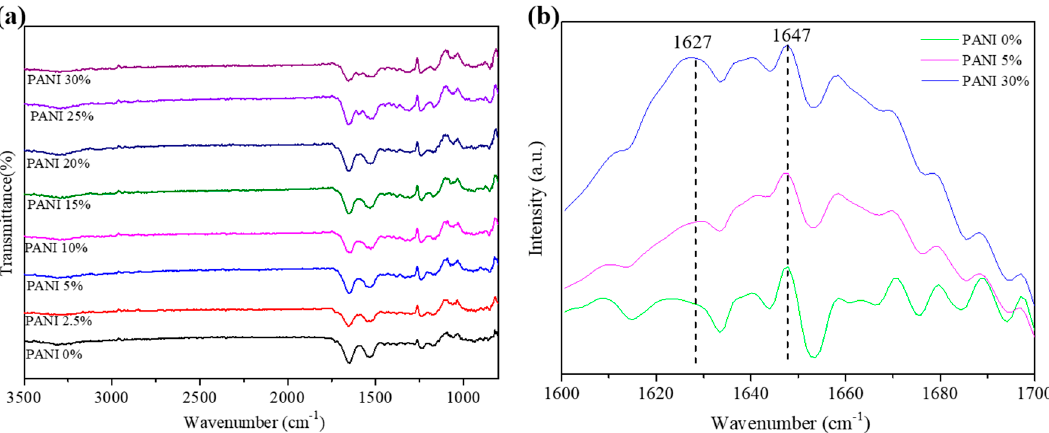
Figure 5. ( a ) FTIR spectra of electrospun PANI/silk mats with various amounts of PANI. ( b ) FTIR spectra of the amide I absorption band.